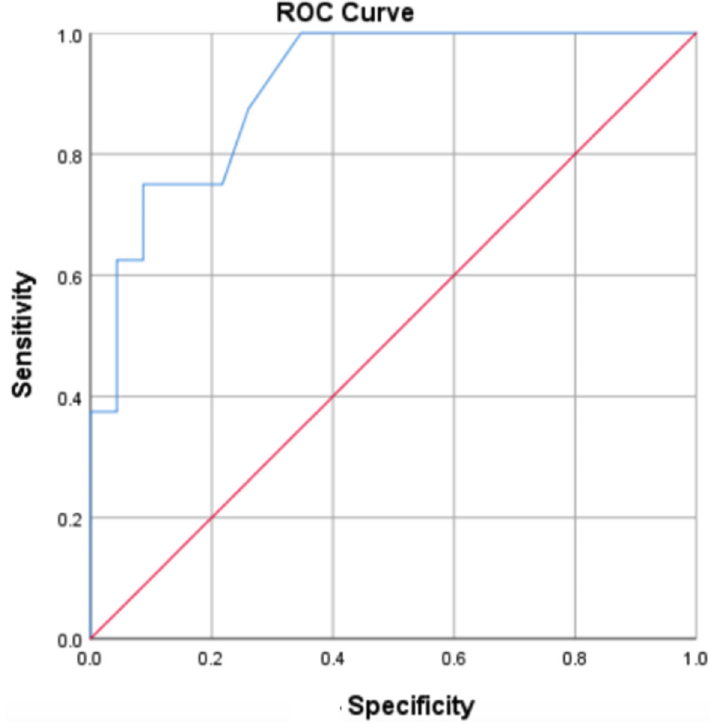
Figure 1. The sensitive and specific of the MTX-PG3 level to determine the change of DAS28-CRP